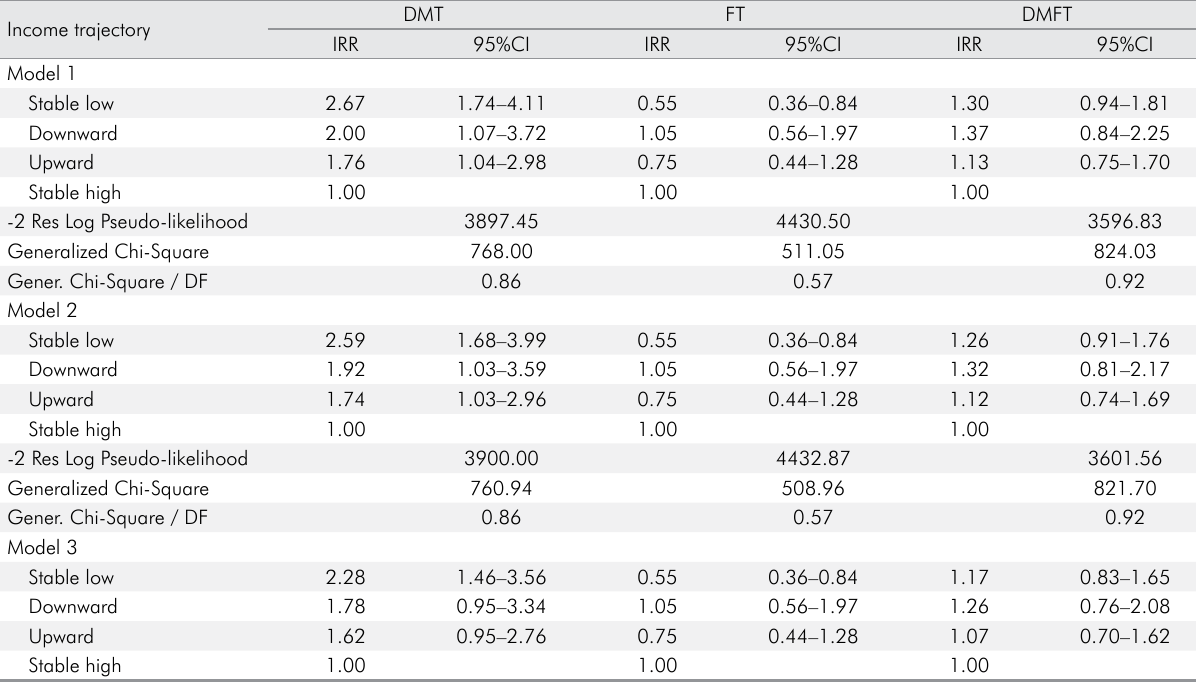
Table 2. Fixed effects of negative binomial models on the association between dental caries increment and family income trajectories. Income